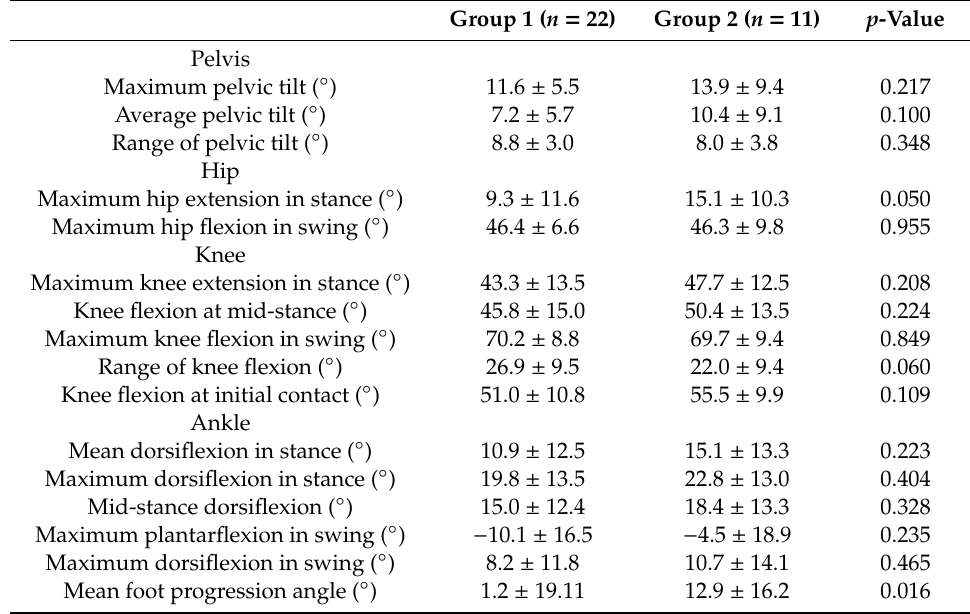
Table 4. Comparisons of preoperative kinematic parameters between the Groups 1 and 2.